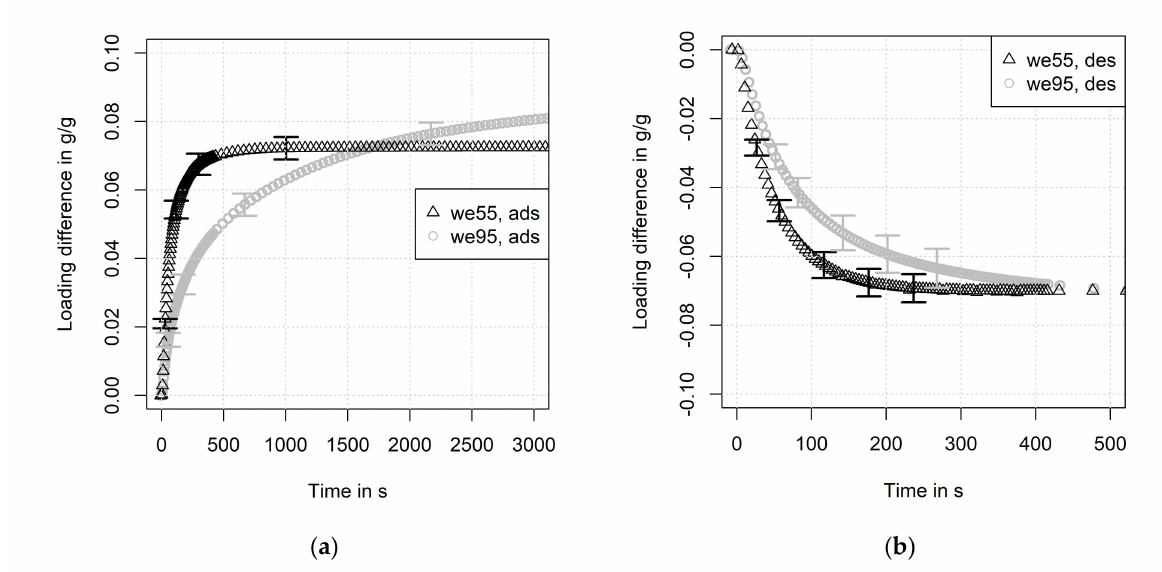
Figure 7. Sorption dynamics of we55 and we95 in terms of loading difference in adsorption ( a ) and desorption ( b ). Error propagation analysis of the loading difference is done according to Equation (13).